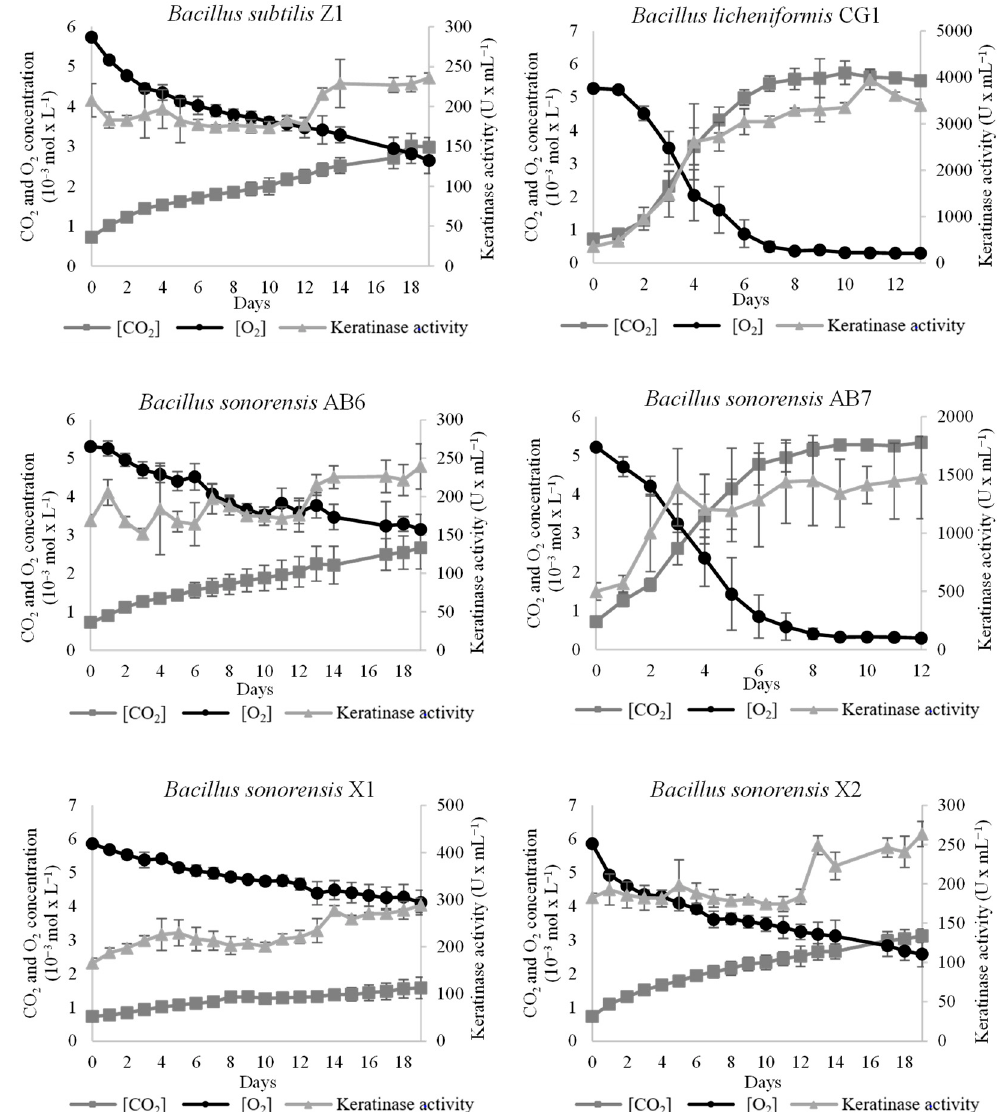
Figure 3. Growth and keratinase activity of the Bacillus isolates on chicken feathers as sole carbon and nitrogen source. Samples for growth (CO 2 production and O 2 consumption) and keratinase activity were collected every 24 h until O 2 was depleted from the bottles or until when 20 days were reached. Vertical error bars correspond to the standard error of the mean of three replicated experiments. Table 3. Summary of the antimicrobial and keratinolytic activities obtained for each of the strains. Anti- Strain